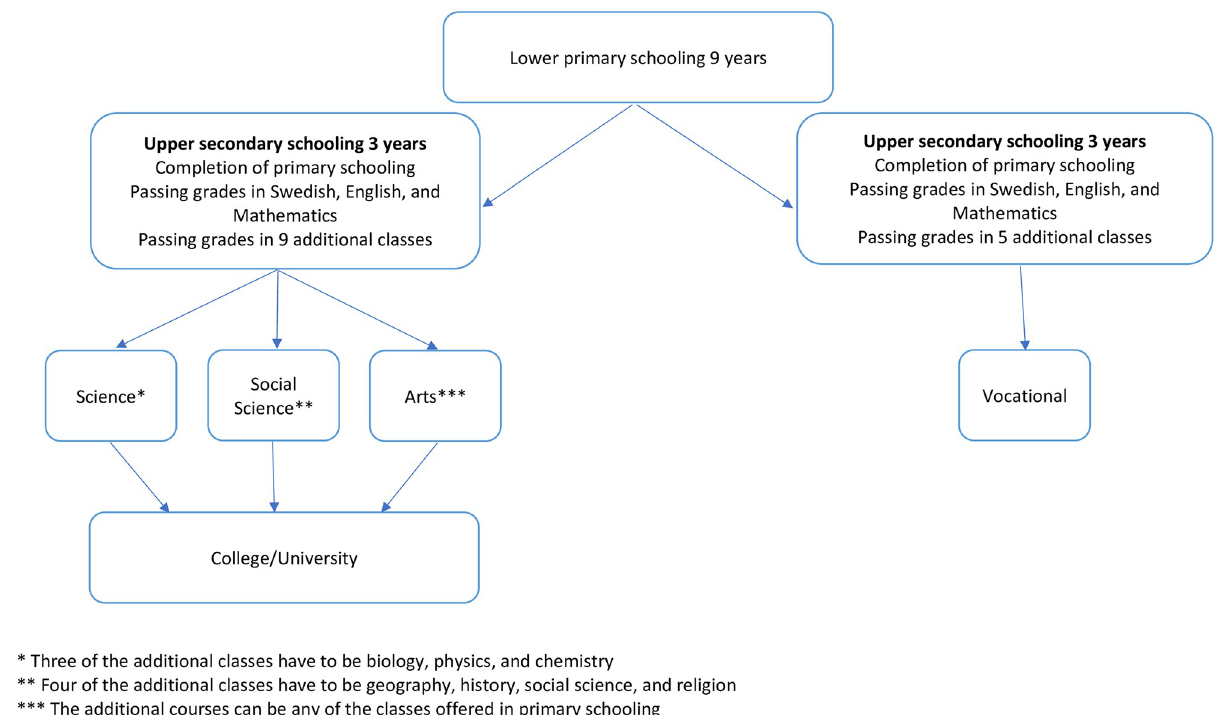
Fig 1. The Swedish school